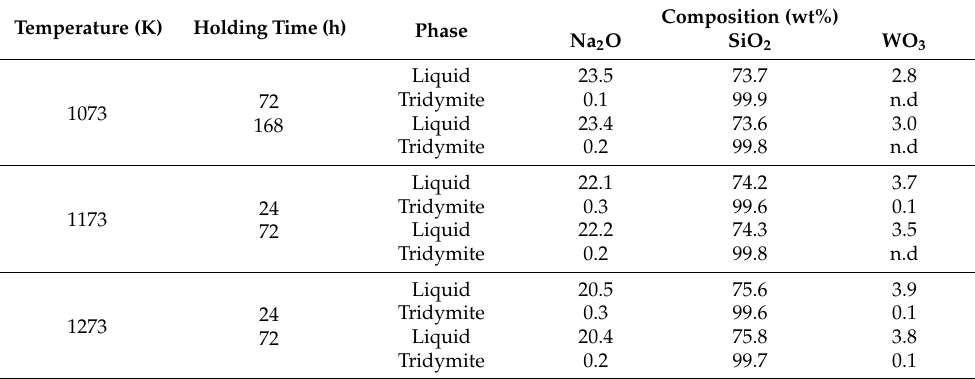
Table 1. Comparison of the samples with same compositions and experimental temperature equili- brated for different times in selected primary phase